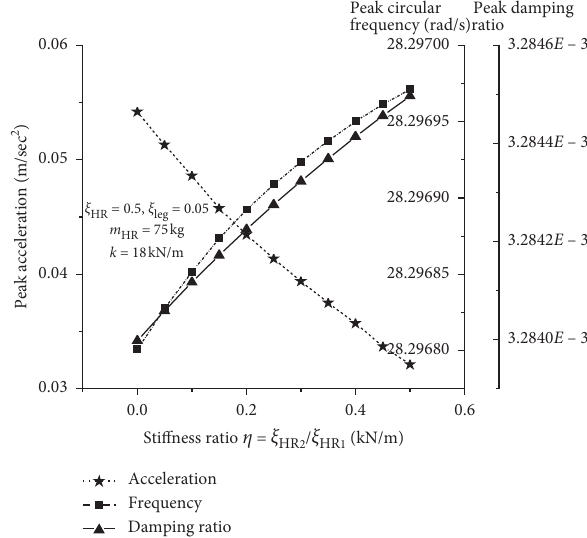
Figure 34: Peak acceleration, frequency, and damping ratio under � 0 . 5, η � 0 . 3, and m � 75. HR HR